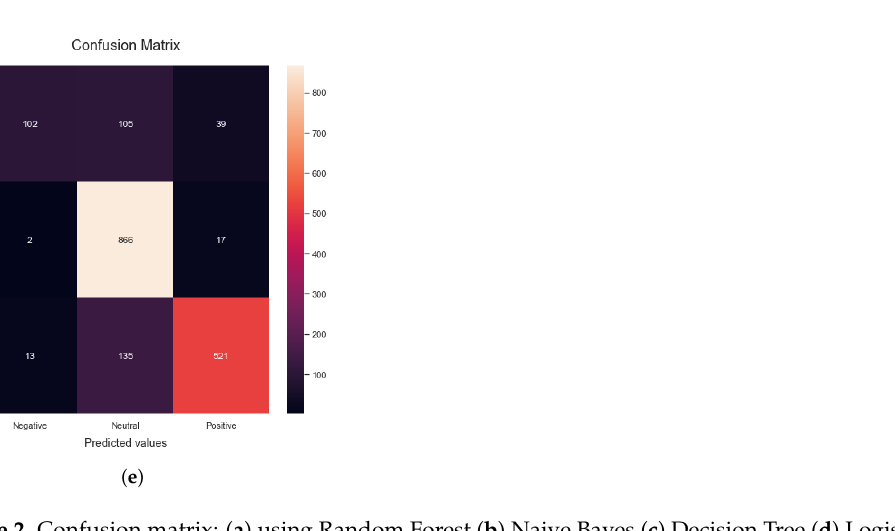
Figure 2. Confusion matrix: ( a ) using Random Forest ( b ) Naive Bayes ( c ) Decision Tree ( d ) Logistic Regression ( e ) SVM. Table 3. Machine learning Performance on COVID-19 vaccine tweets with sentiment